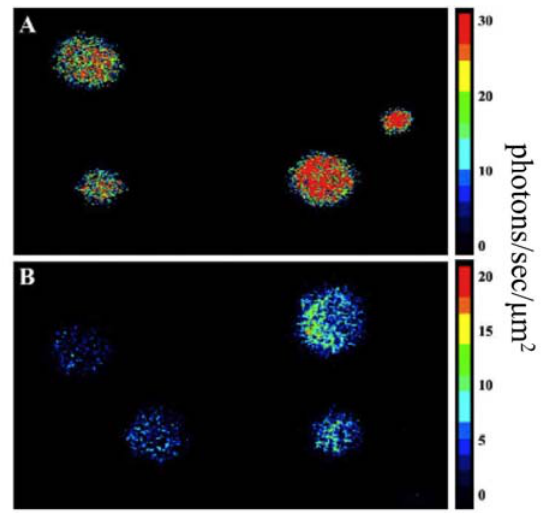
Figure 5. Comparison of ( A ) S. cerevisiae and ( B ) E. coli expressing the luxCDABEfrp genes. Used with permission from